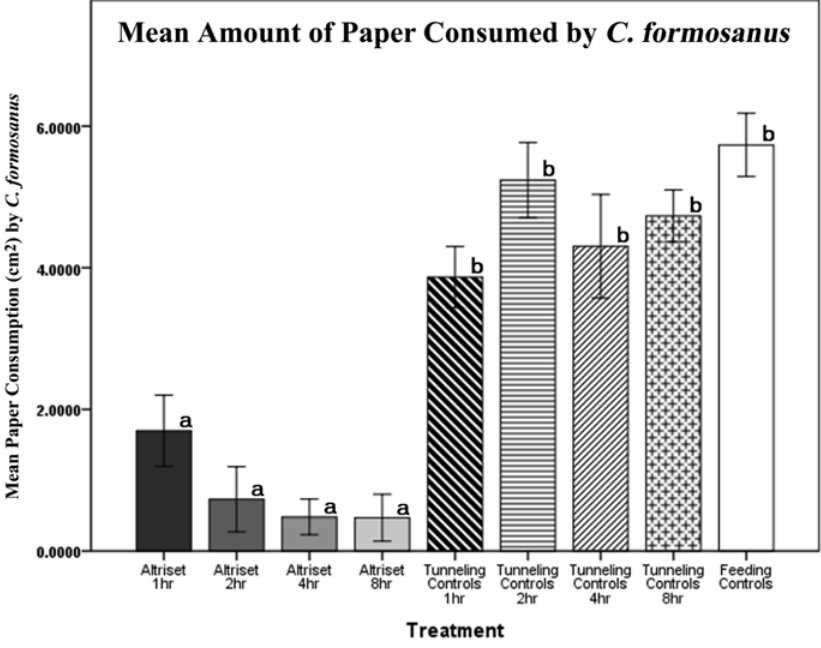
Fig. 2. Mean paper consumed (cm2) by FST through 12 d after exposure to chlorantraniliprole treated soil, untreated soil, or no soil. Treatments were replicated 10 times. Bars with the same letter are not significantly different using Analysis of Variance (ANOVA) and Tukey’s HSD mean separation test at P <